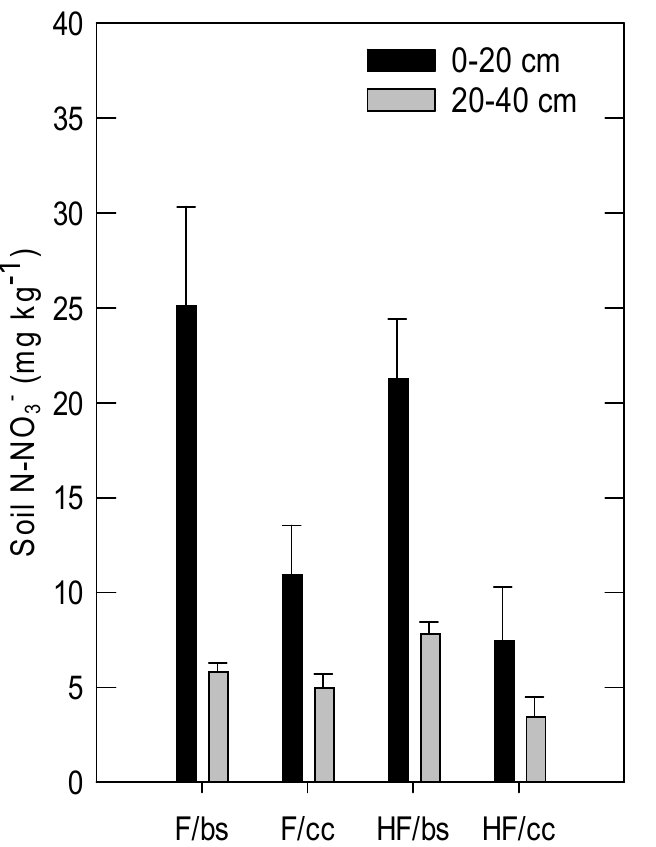
Figure 4. Effects of the fertigation dose (farmer (F) and half farmer (HF)) and soil management (bare soil (bs) and cover crops (cc)) on the soil N-NO 3 − concentration at two depths. Data shows the mean ± standard error. Table 5. Effects of the fertigation dose (Do), soil management (SM) and the soil depth (De) and its interactions on the total soil carbon (Total C), total soil organic carbon (Total org C), total soil N (Total N) and soil N-NO 3- concentration.